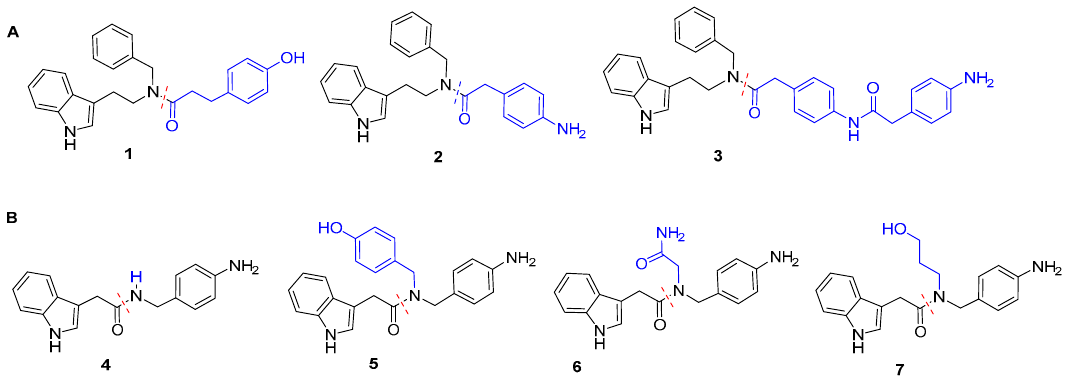
Figure 2. ( A ) Structures of the acyl N -benzyl tryptamine amides 1–3 , prepared according to path A, and ( B ) of the indolyl acetic acid amides 4–7 obtained via path B. The variable groups are rendered ( B ) of the indolyl acetic acid amides 4 – 7 obtained via path B. The variable groups are rendered in blu. in blu.